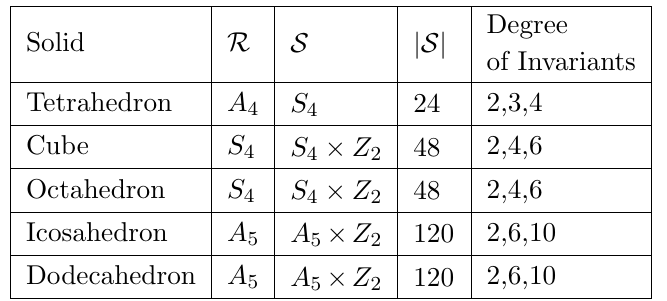
Figure 5. The A 4 symmetric one loop potential for m = 1, y = 0 : 5, f potential is no longer (cid:13)at at the origin. The mode (cid:25) 1 (cid:0) (cid:25) 2 p tachyonic mass at (0 ; 0).